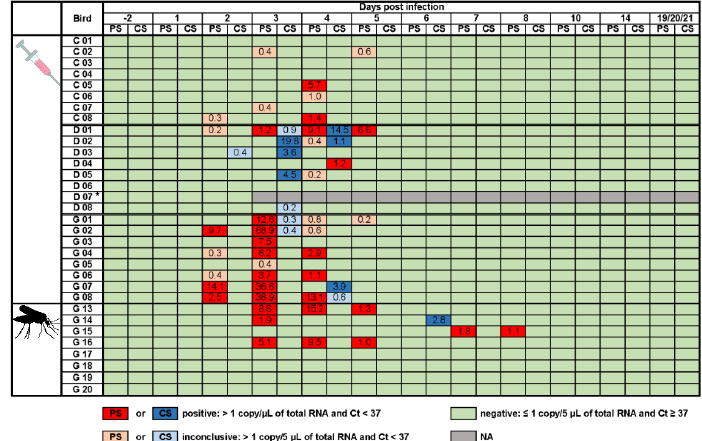
Figure 2. Viral shedding of chickens (C), ducks (D), and geese (G) after subcutaneous injection with WNV or the bite of WNV-infected mosquitoes. Numbers indicate the viral copies/µL of total RNA of positive or inconclusive oropharyngeal (PS in dark or light red) and cloacal (CS in dark or light blue) swabs. Asterisk indicates one duck (D 07) that succumbed early after infection, so that swab samples could only be taken one and two days post infection. NA stands for not applicable. Ct stands for cycle